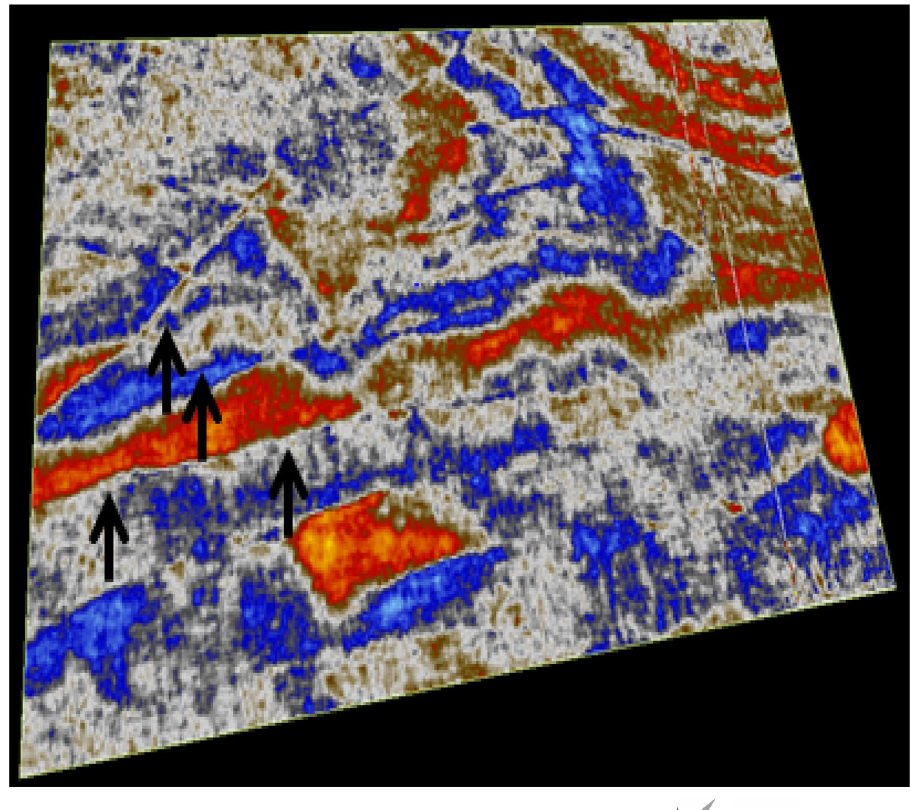
Fig. 6 Normal seismic amplitude. This figure shows the normal seismic amplitude indicating the picked faults on the